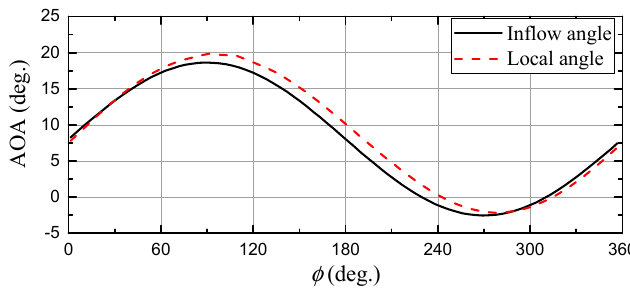
Figure 9. Comparison between the inflow angle and the local angle. Appl. Sci. 2018 , 8 , x FOR PEER REVIEW